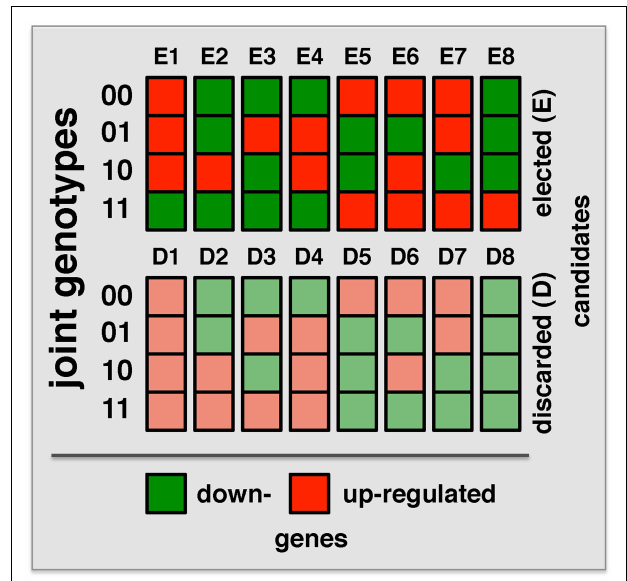
FIGURE 3 | Combinations of binary locus genotypes and binary expression levels make up 16 different configurations. Binary numbers on the left refer to the locus genotype while the colors of the squares indicate gene expression levels (low/high).The method uses expression pattern for loci 00/01/10 to predict expected expression level for pair 11 under single locus or non-interaction model. For example, configurations E4 and E5 correspond to “XOR” function where the expression patterns depend on whether both loci are inherited from the same or from two different